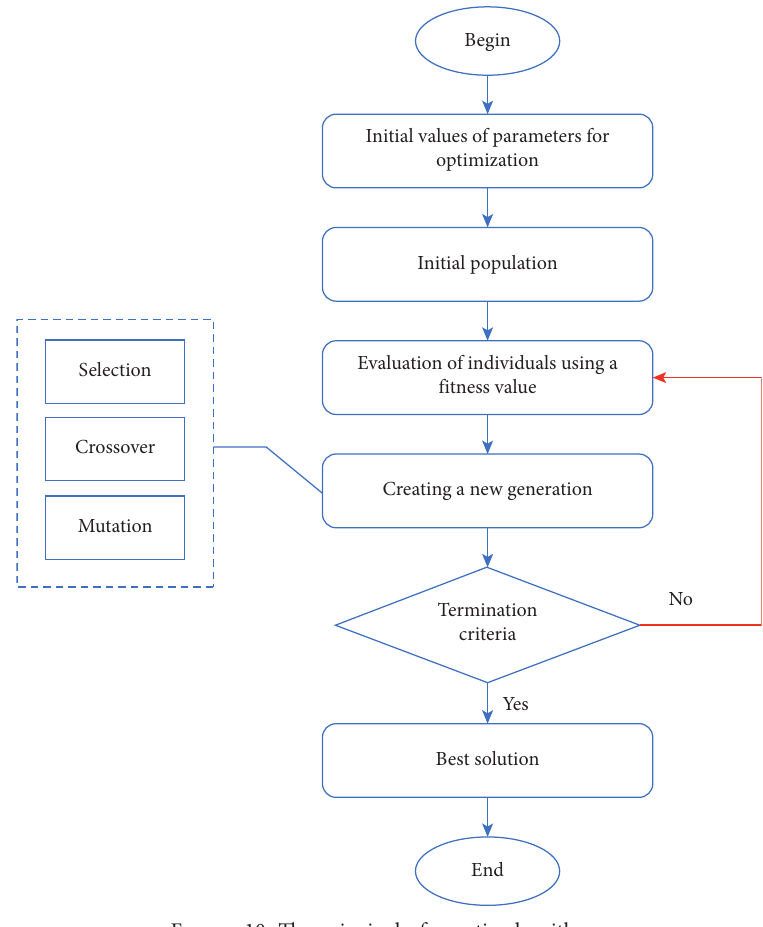
Figure 10: The principal of genetic algorithms.